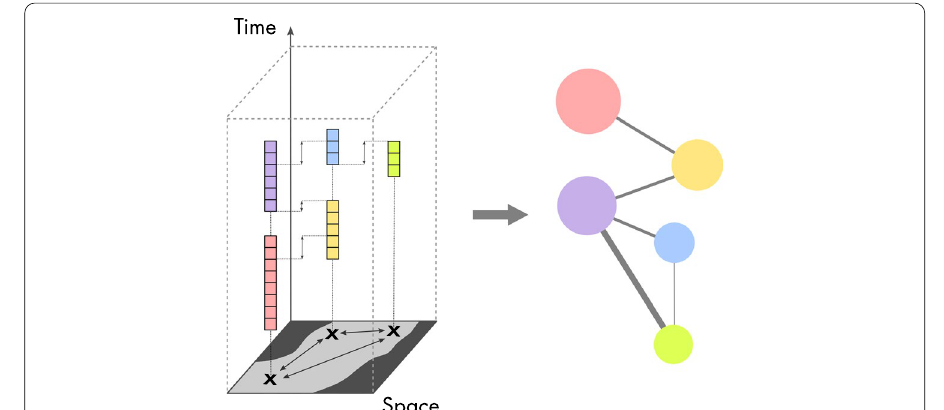
Fig. 1 Illustration of the methodology used to extract resting event networks from spatio-temporal trajectories. Resting events are characterized by their duration, day of occurrence and location. A link is created between two events if they overlap in time on a daily basis. The weight of a link corresponds to the distance between events’